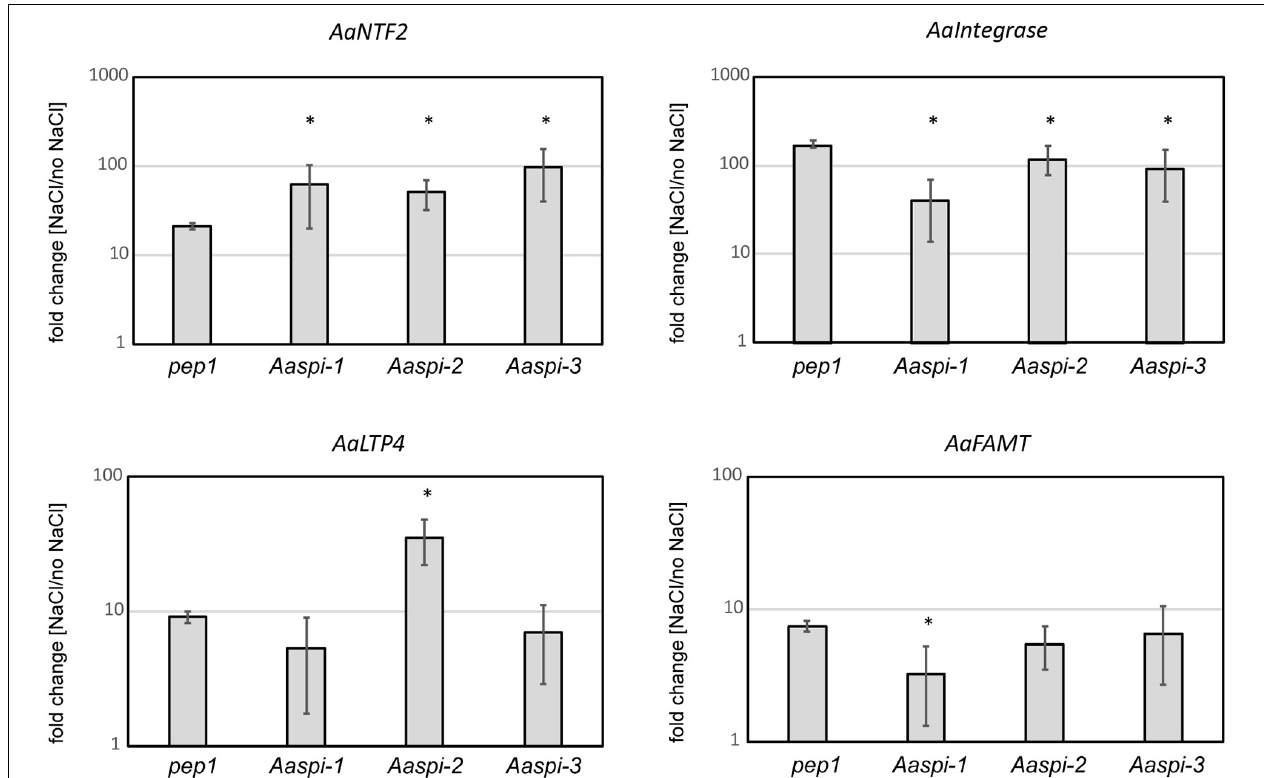
FIGURE 10 | Relative transcript levels in pep1 and Aaspi mutants in response to salt stress. Normalization was carried out against AaCAC and AaTUA5 . Error bars depict standard deviation. Significance was determined using a Mann-Whitney-U test at * p <